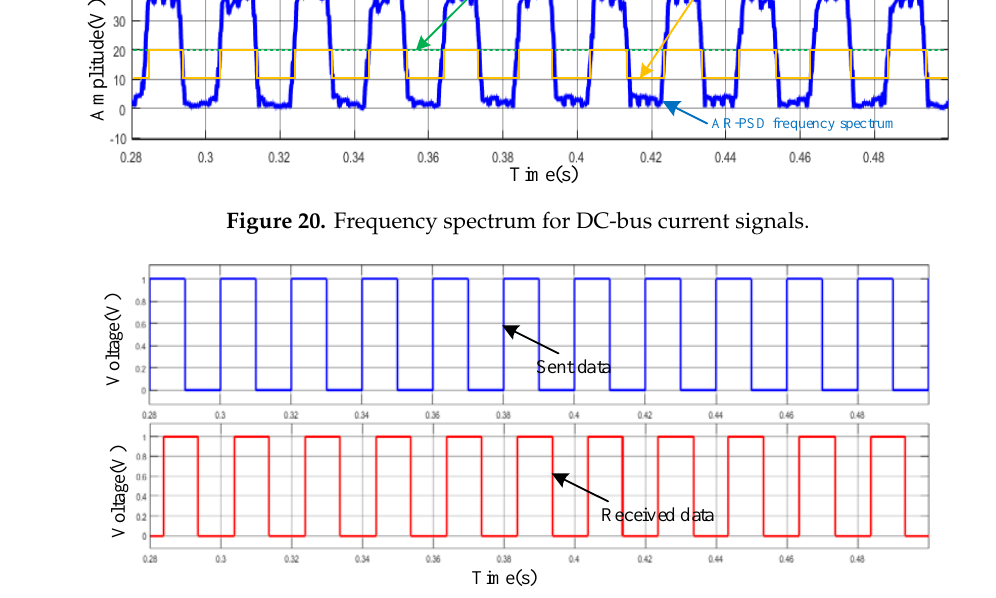
Figure 21. Simulation results of signal sending and receiving.